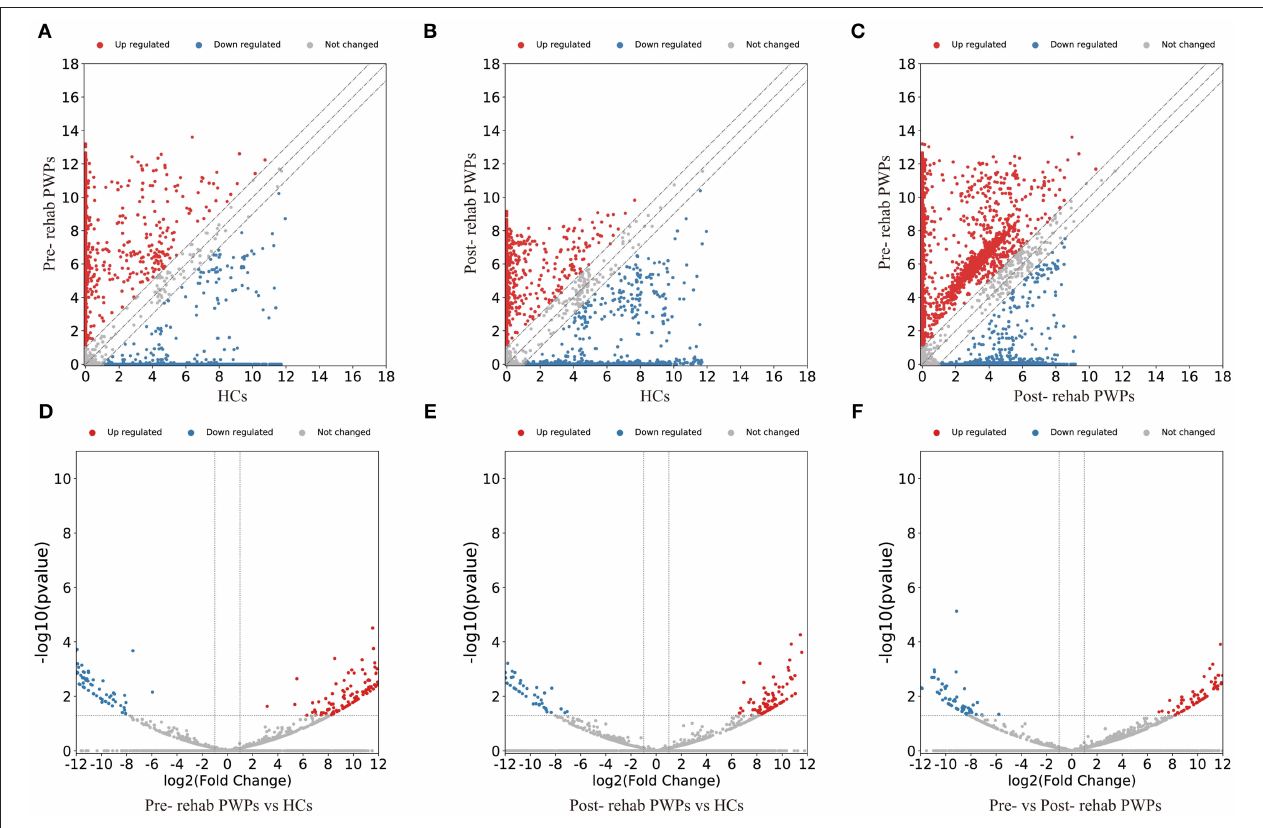
FIGURE 3 | Changes in the lncRNA expression profiles of the HCs, pre- and post-rehab PWPs. The scatter plot (A) and volcanic map (D) reveal that a significant difference existed in the distribution of lncRNAs between pre-rehab PWPs and HCs. The scatter plot (B) and volcanic map (E) reveal that a significant difference existed in the distribution of lncRNAs between post-rehab PWPs and the HCs. The scatter plot (C) and volcanic map (F) reveal that a significant difference existed in the distribution of lncRNAs between Pre- and Post-rehab PWPs. Red represents upregulation, while green represents downregulation. Pre-rehab, pre-rehabilitation; Post-rehab, post-rehabilitation; PWPs, patients with Parkinson’s